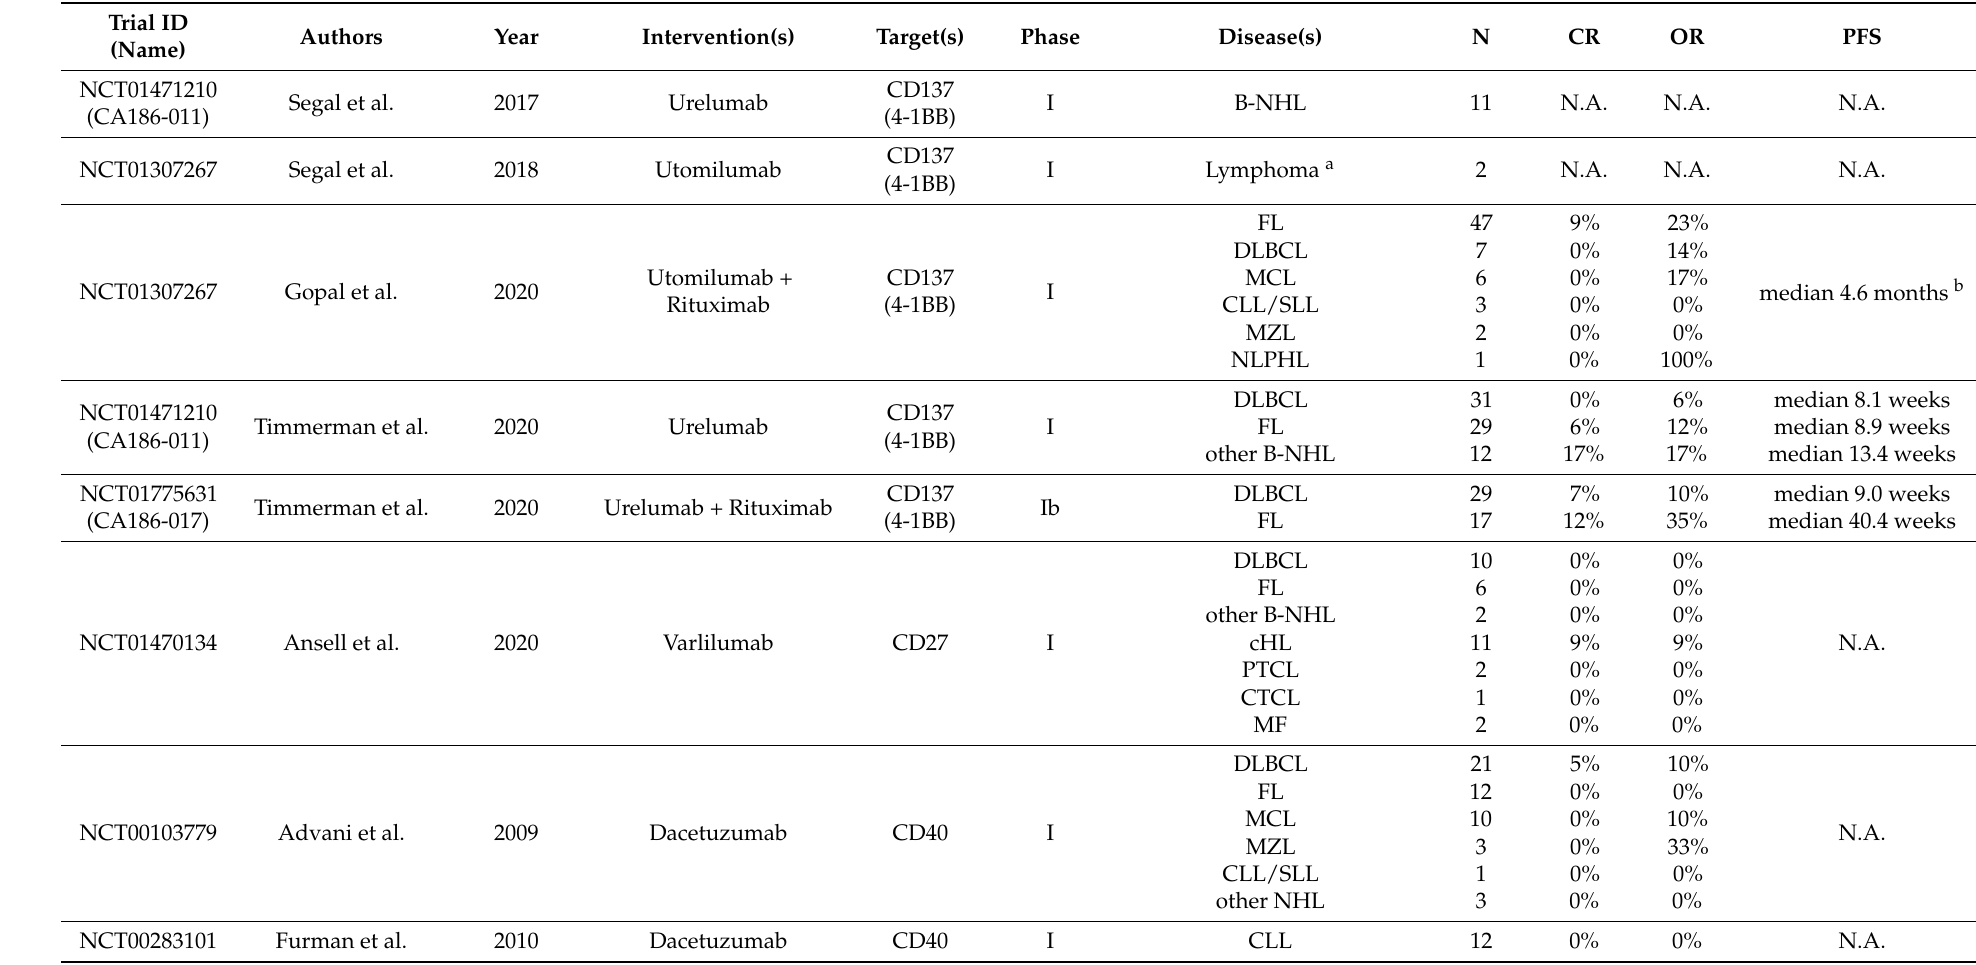
Table 7. Clinical trials of immune checkpoint stimulators in